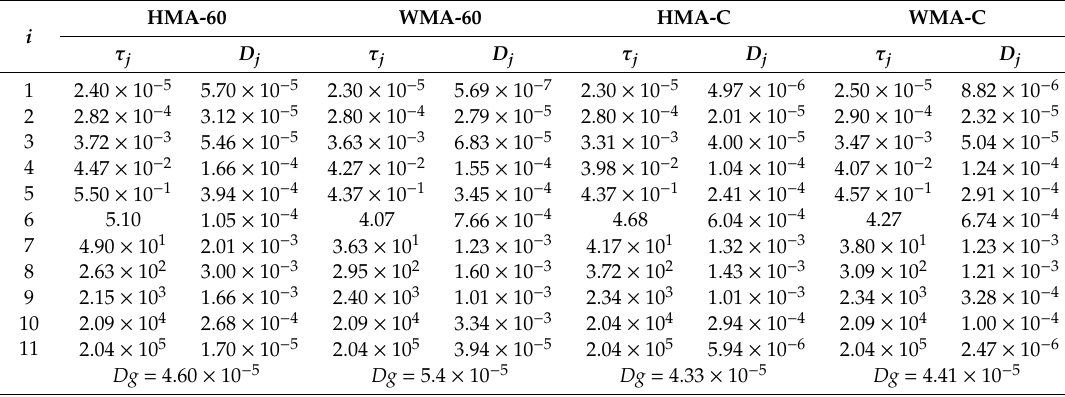
Table 10. Discrete retardation spectrum of crumb rubber-modified asphalt mixture